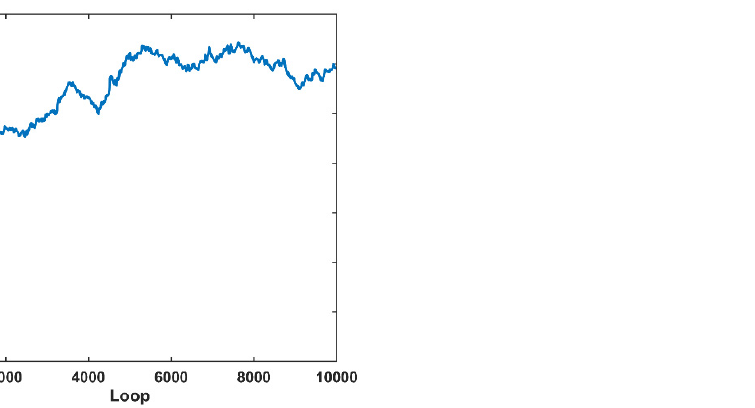
Figure 13. Simulated surface roughness for monocrystalline silicon after repolishing with pure colloidal silica slurry for 10,000 iterations.